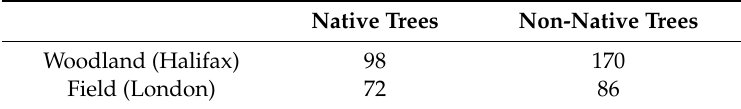
Table A2. Contingency table for test “N” (new neighbourhoods).